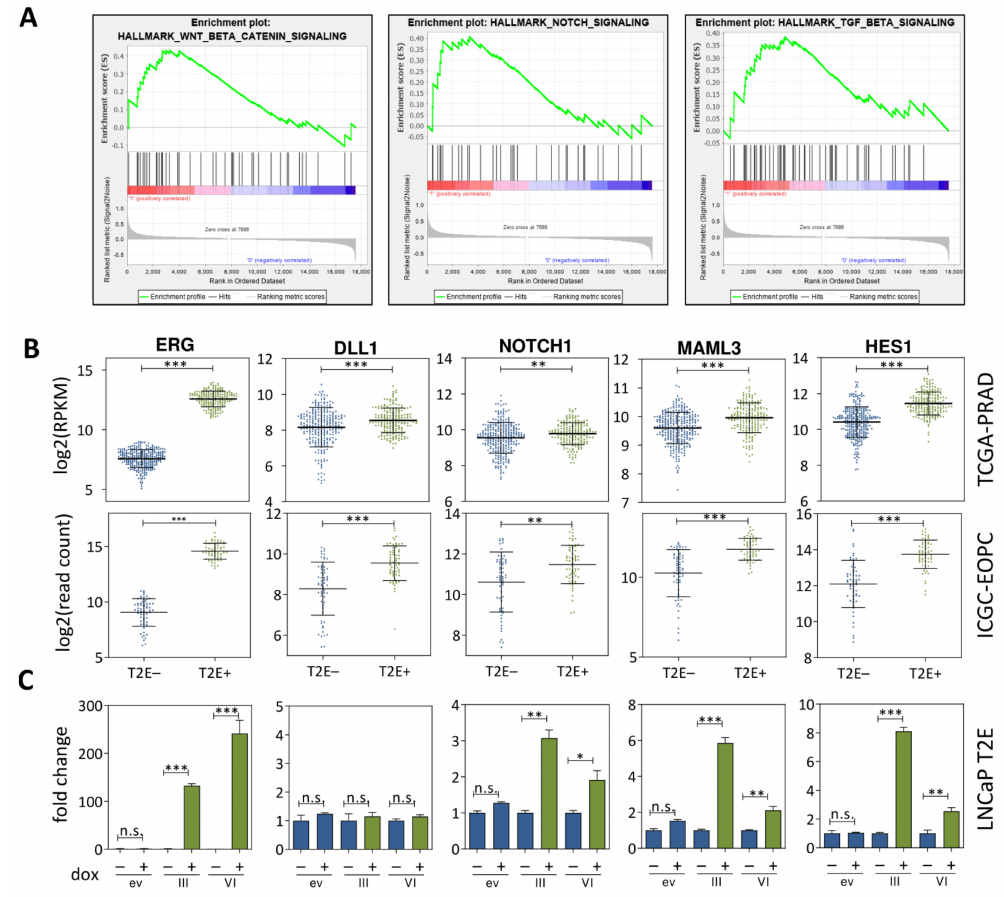
Figure 2. NOTCH signaling is enhanced in T2E+ tissue specimens and cell lines. ( A ) Gene set enrichment analysis plots identifying WNT/ β -catenin, NOTCH and TGF- β signaling as positively enriched sets in T2E+ compared to T2E − patient samples. ( B ) Expression of ERG and four NOTCH signaling genes separated according to T2E fusion (T2E − , T2E+) status estimated from ERG expression of TCGA-PRAD and ICGC-EOPC data. ( C ) Fold changes of mRNA expression measured via qPCR of NOTCH signaling genes in LNCaP T2E cells. Empty vector (ev), T2E fusion variant III (III), and T2E fusion variant VI (VI) were treated with PBS ( − ) or doxycycline (+). Bars representing cells with ERG overexpression are displayed in green and control bars in blue (n.s. not significant, * p ≤ 0.05; ** p ≤ 0.01; *** p ≤